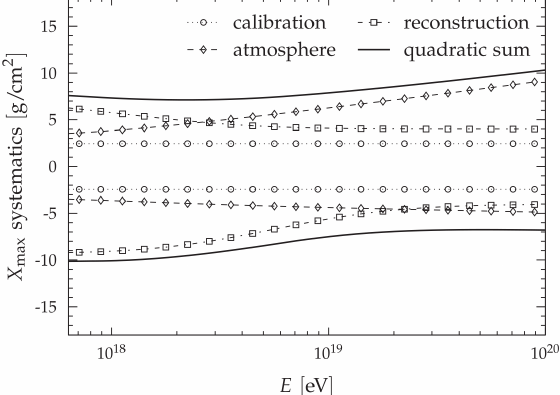
Figure 9. X max systematic uncertainty as a function of the en- ergy. The aerosol uncertainties are the main contribution to the “atmosphere”